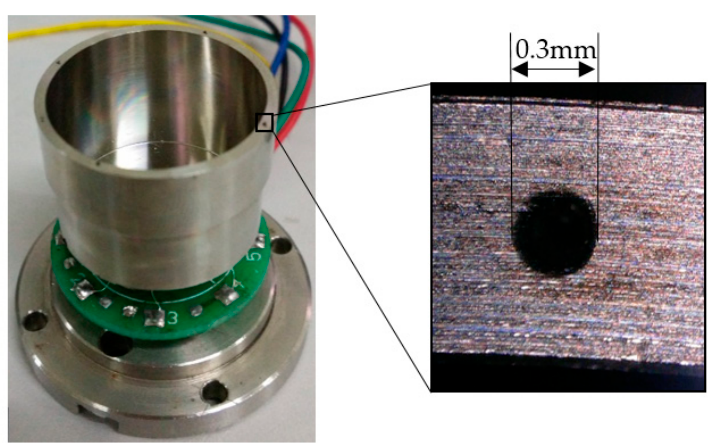
Figure 12. Drilling holes on the top of the wall in the experiment.